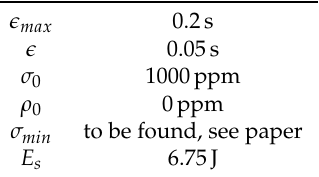
Table 2. Initial values and constants for the